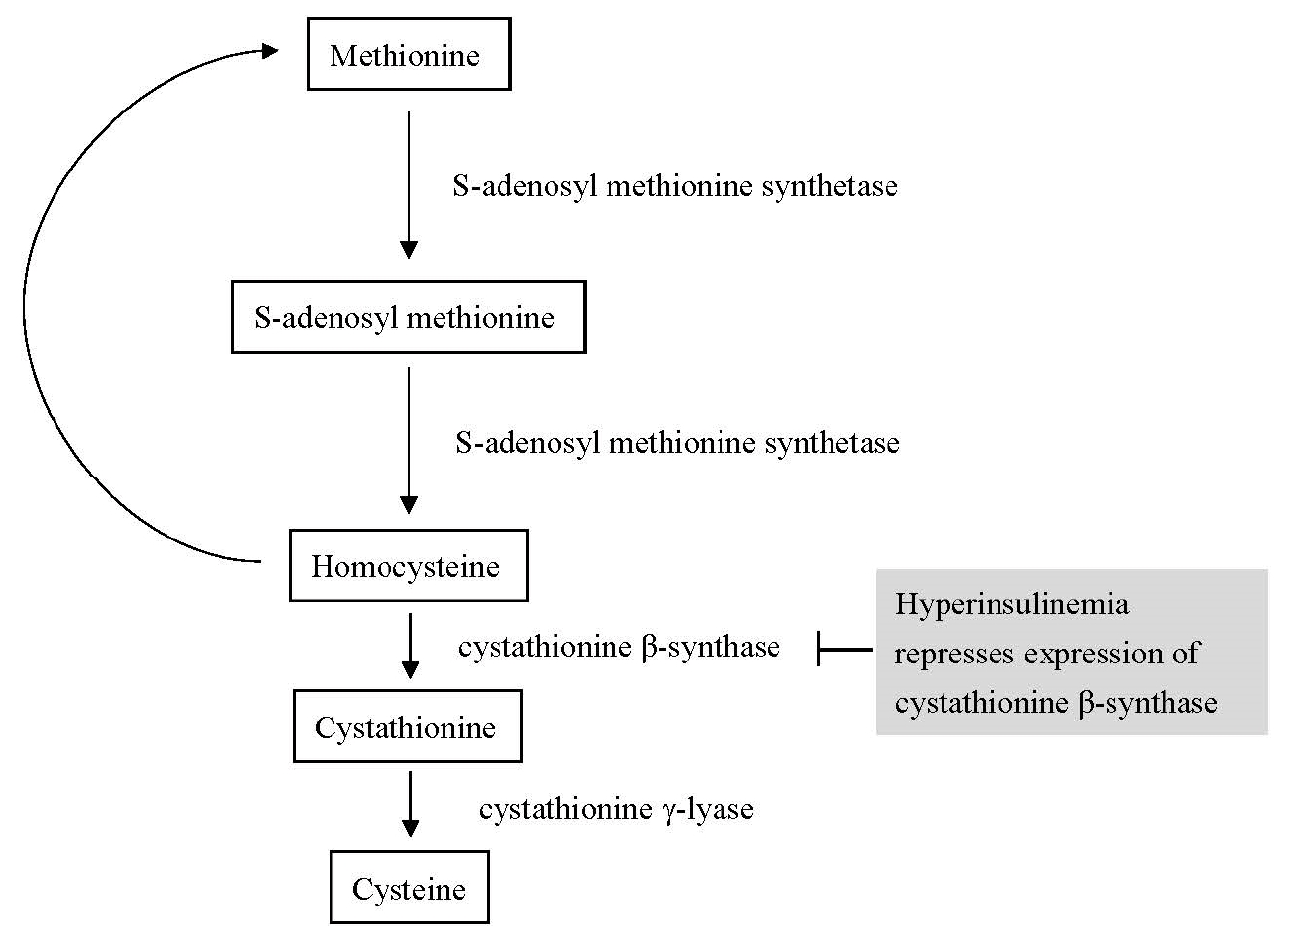
Figure 6. Interaction between homocysteine metabolism and hyperinsulinemia.